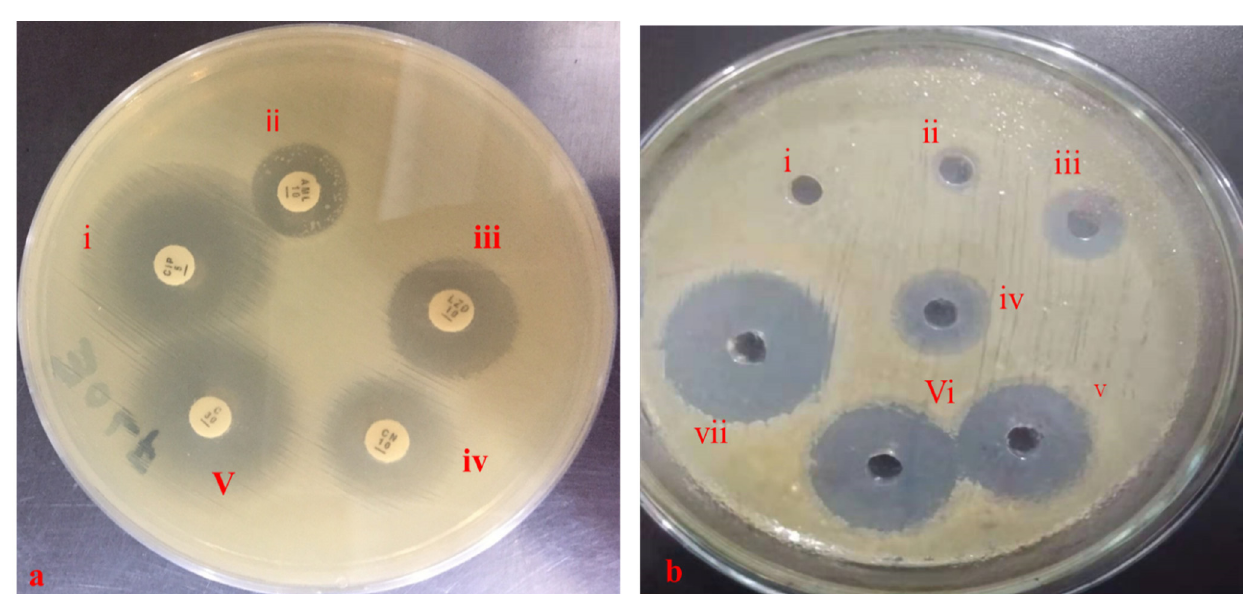
Figure 4. Antibacterial activity of different antibiotics/drugs against E. coli using disc diffusion and well diffusion test. ( a )